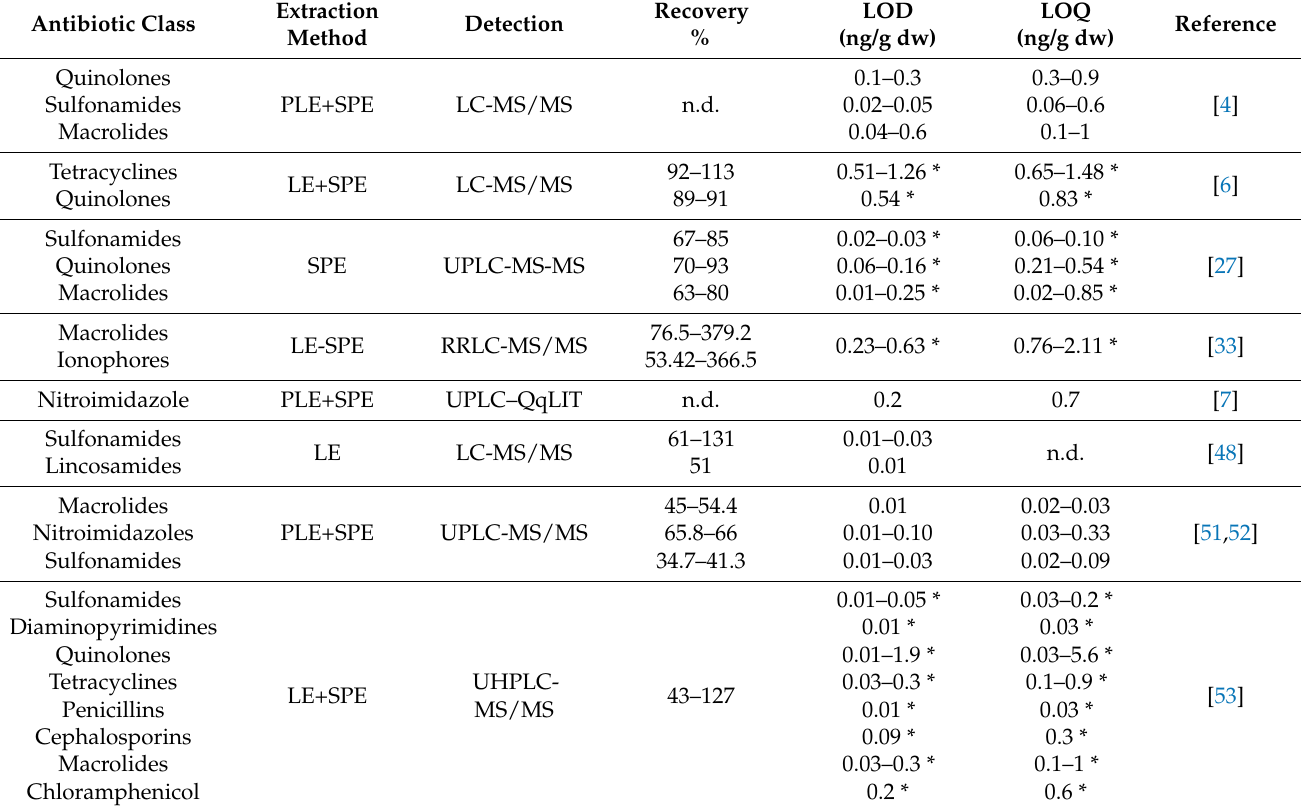
Table 1. Methods used to quantify antibiotics in bivalve